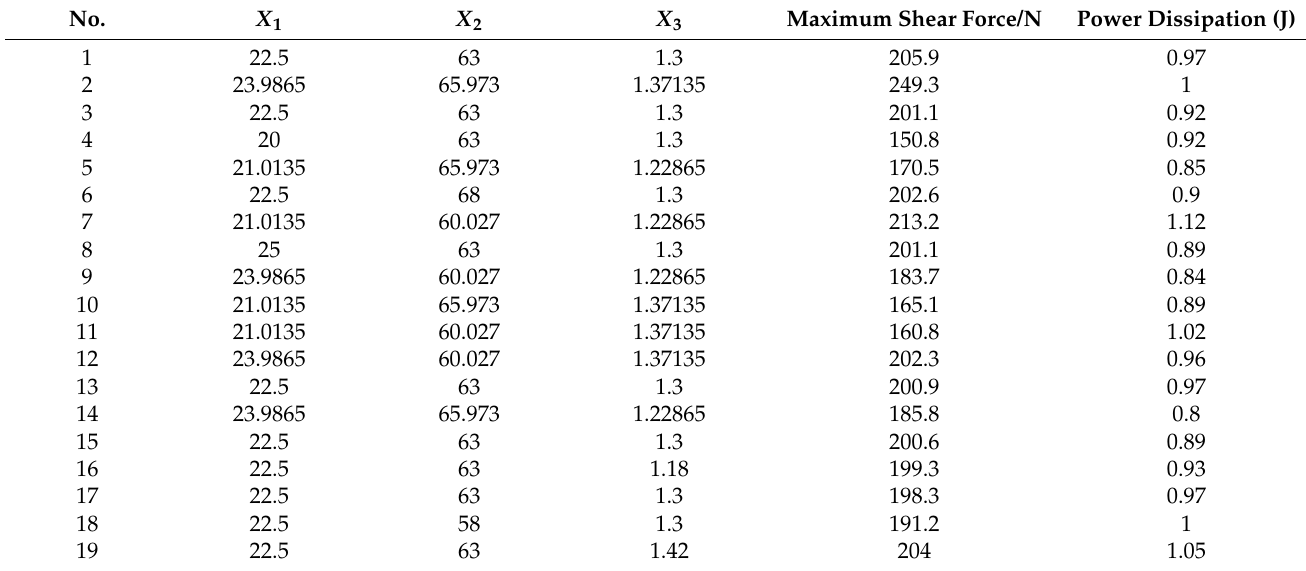
Table 5. Results of the central composite